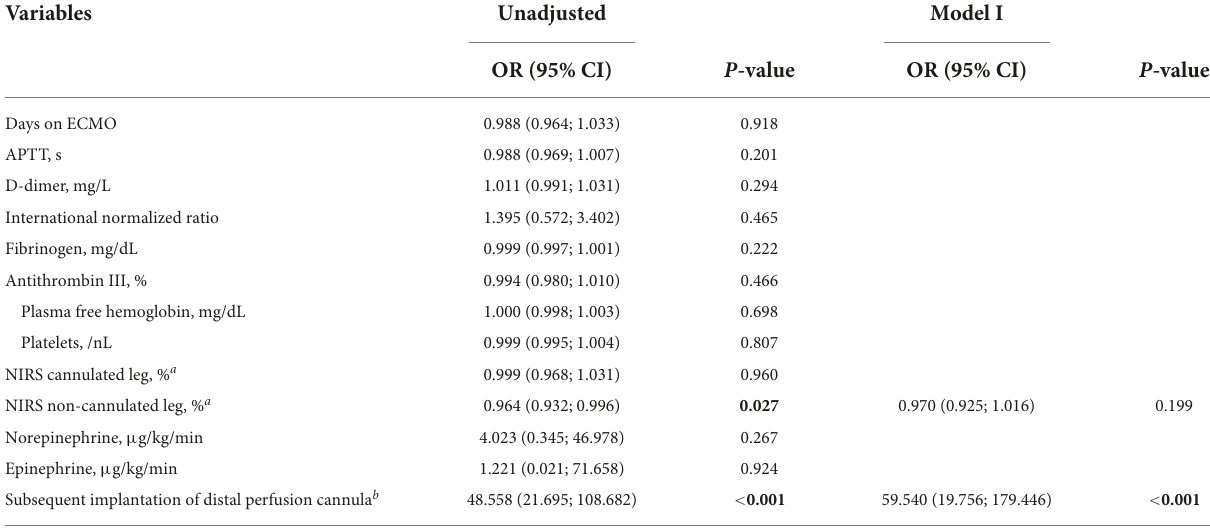
TABLE 5 Univariate and multivariate binary logistic regression models for limb ischemia over the entire duration of ECMO support in survivors of venoarterial extracorporeal membrane